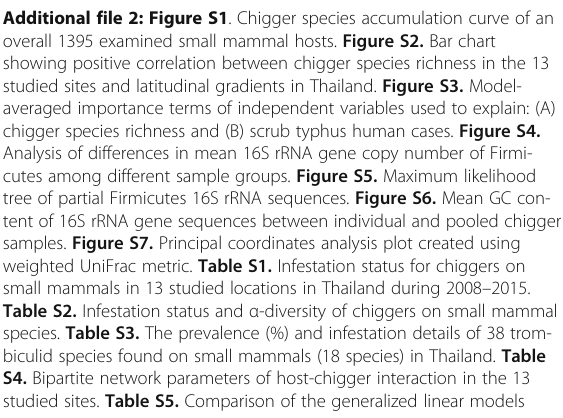
small mammals in 13 studied locations in Thailand during 2008 – 2015. Table S2. Infestation status and α -diversity of chiggers on small mammal species. Table S3. The prevalence (%) and infestation details of 38 trom- biculid species found on small mammals (18 species) in Thailand. Table S4. Bipartite network parameters of host-chigger interaction in the 13 studied sites. Table S5. Comparison of the generalized linear